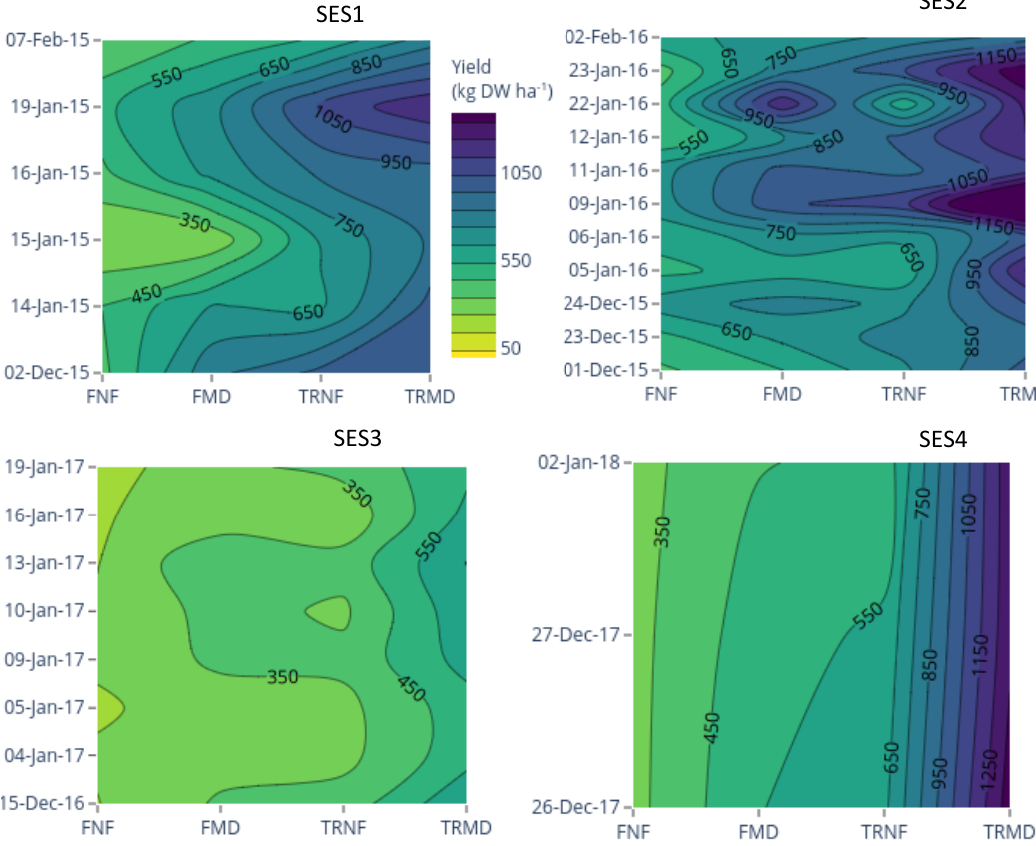
Figure 4. Pearl millet mean yields from the interaction between planting dates and treatments (the treatments (X-axis) are FNF, which denotes flat cultivation without microdosing; FMD, which denotes flat cultivation with microdosing; TRNF, which denotes tied ridge cultivation without microdosing; and TRMD, which denotes tied ridge cultivation with microdosing).